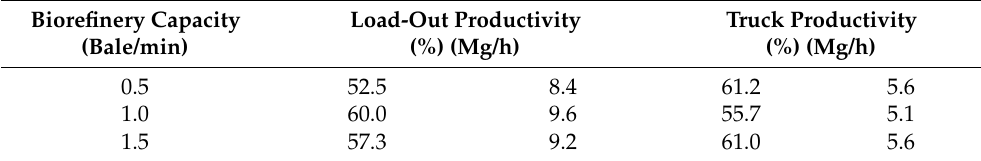
Table 8. Labor productivity of load-out operator and truck